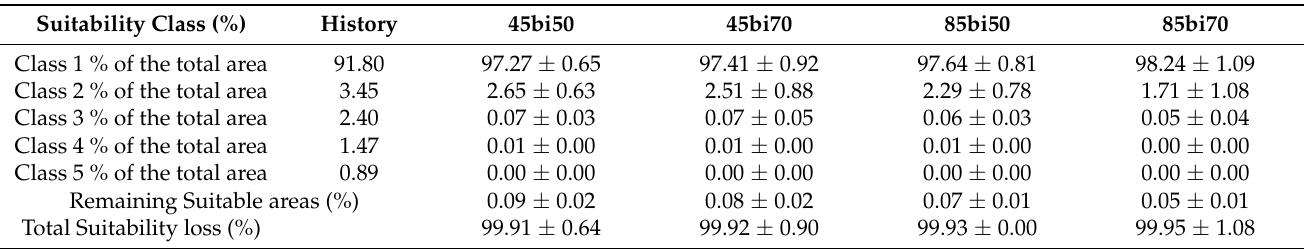
Table 4. Matrix of percentages of suitability class distribution and changes in suitability in the actual distribution classes to the projected distribution classes under the future climatic conditions.